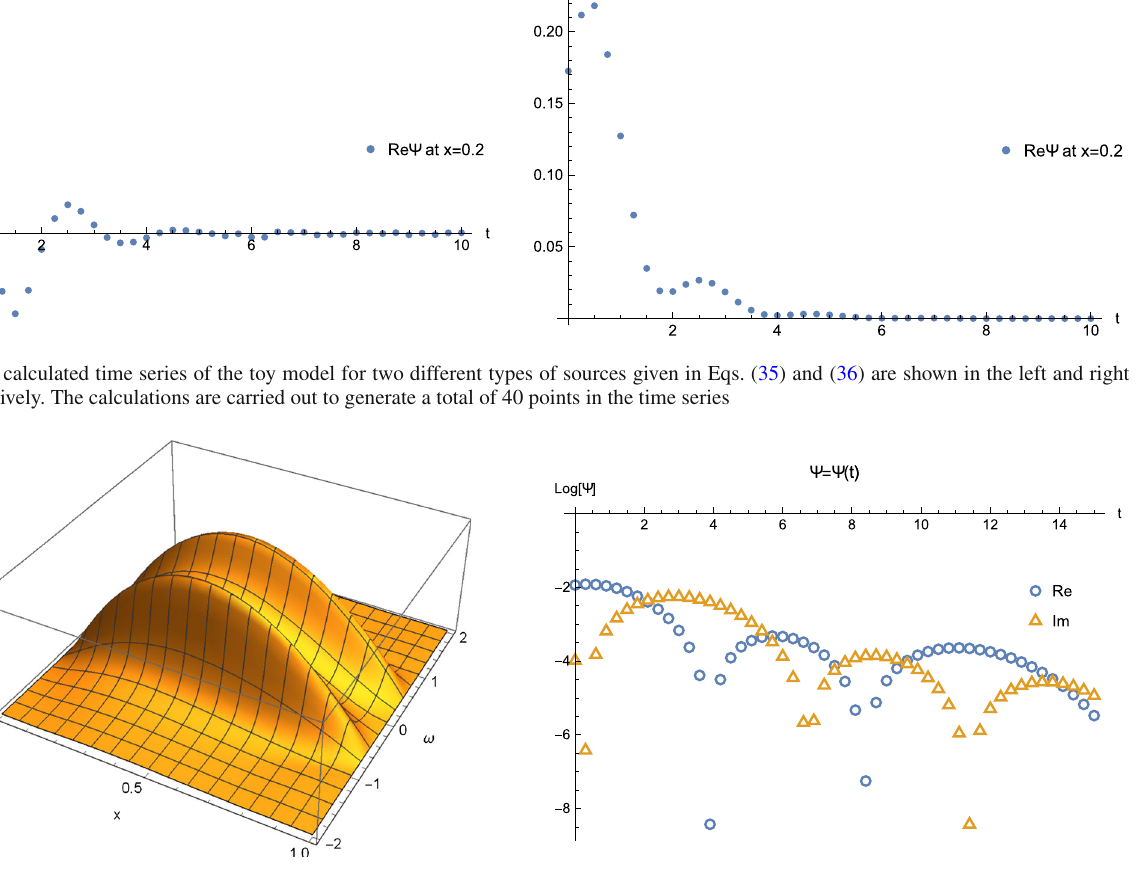
Fig. 2 ResultsonmasslessscalarperturbationsinSchwarzschildblack hole metric with external source. Left: The calculated imaginary part of the numerical solution of the master equation in the frequency domain,